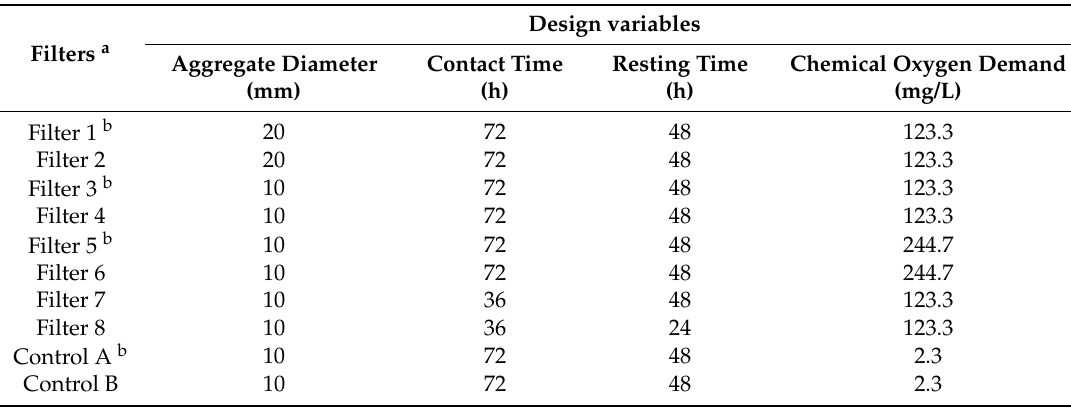
Table 1. Comparison of the experimental vertical-flow wetland